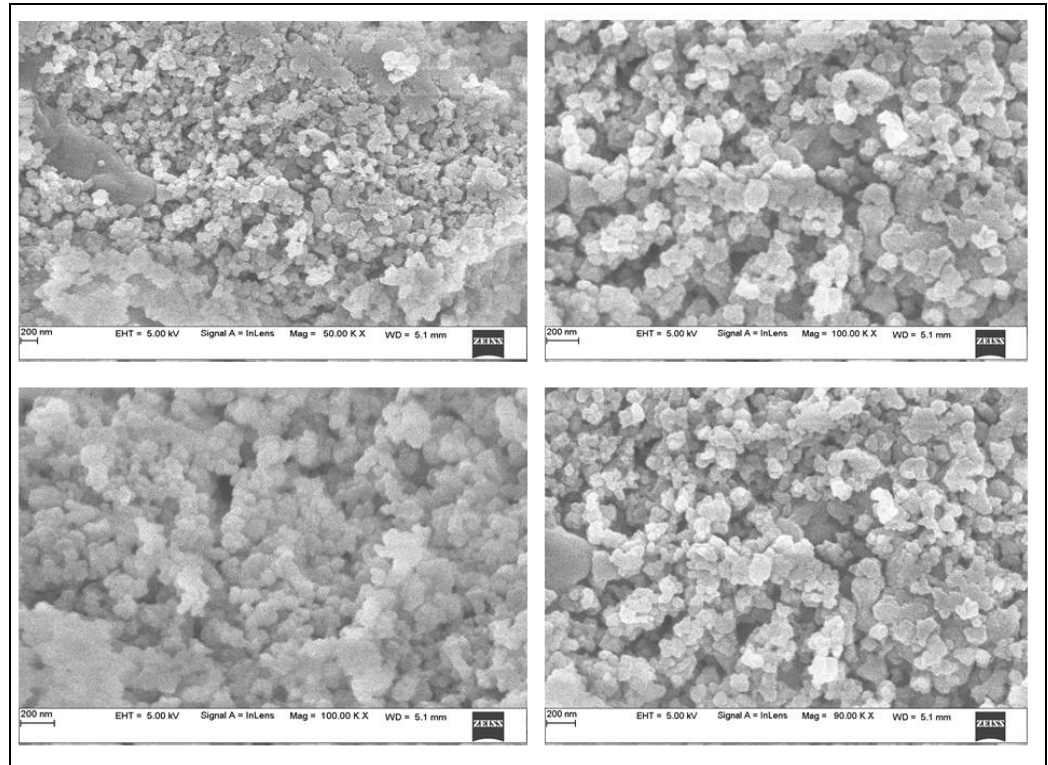
Figure 2. SEM images of spherical-shaped FeNPs.